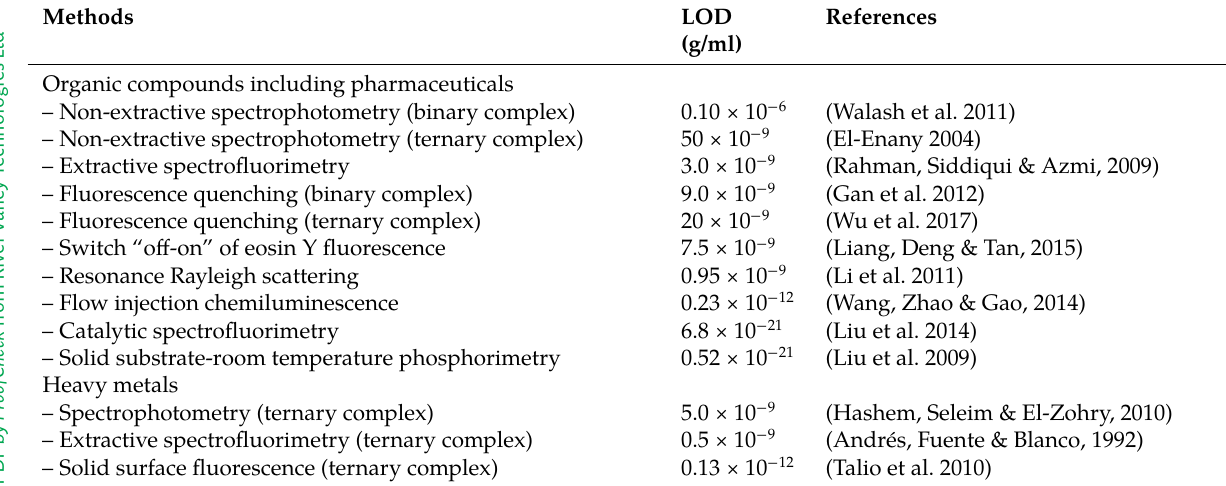
Table 6: Comparison between the sensitivity of the reported methods for the determination of both organic compounds and heavy